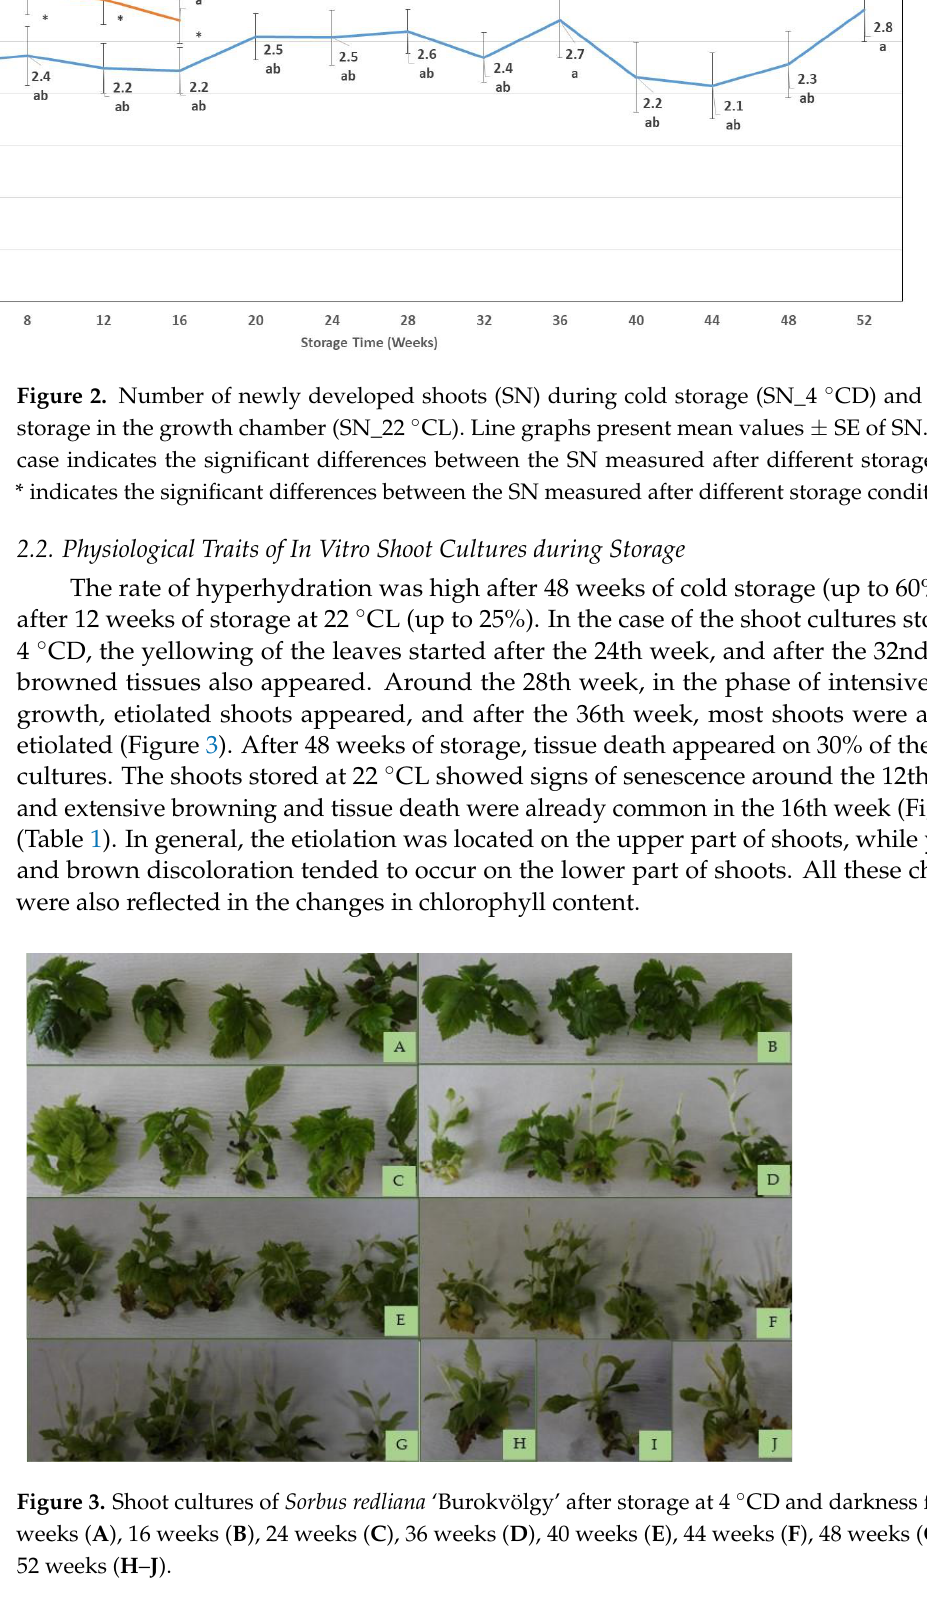
Figure 4. Shoot cultures of Sorbus redliana ‘Burokvölgy’ after storage at 22 °CL and 16 h light for four weeks ( A ), 8 weeks ( B ), 12 weeks ( C ), and 16 weeks ( D ). Table 1. The rate of physiological changes observed for the in vitro shoot culture of S. redliana ‘Bu- rokvölgy’ stored under cold condition (4 °CD) and the growth chamber (22 °CL). Storage Weeks